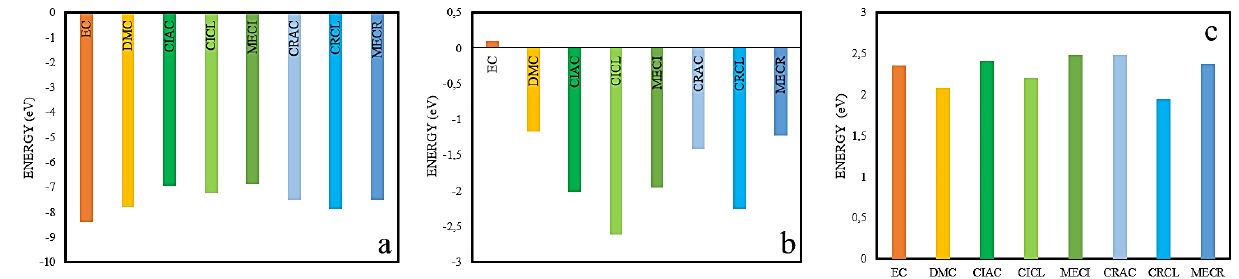
Figure 2. Comparing the energy level of the HOMO ( a ) and LUMO ( b ) molecular orbitals and the lithium-binding energy ( c ) of the studied structures with the base electrolyte solvents.